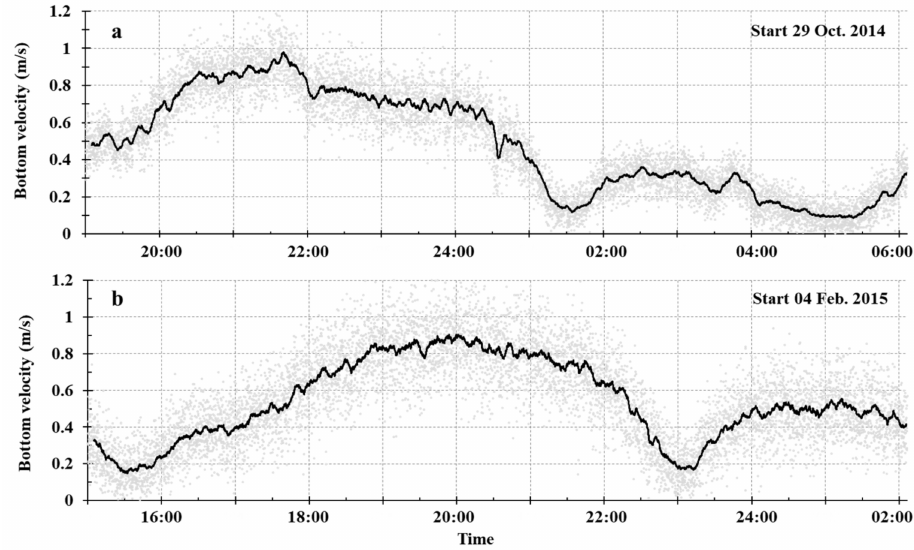
Figure 5. Neap and spring tide cycles during the ( a ) flood, and ( b ) dry